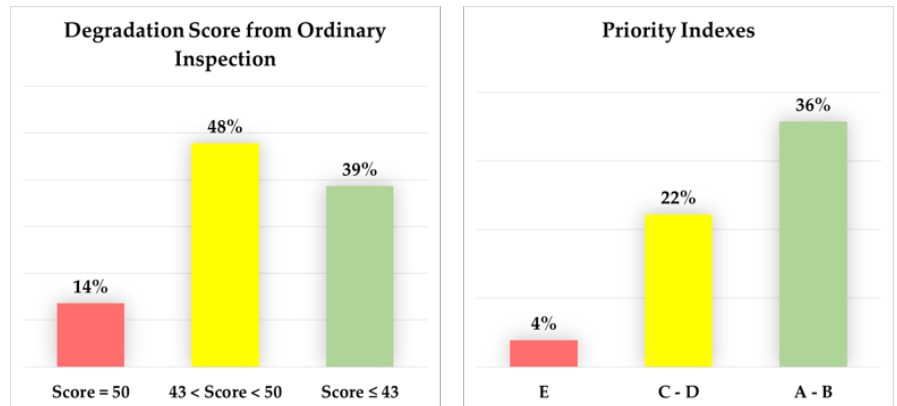
Figure 10. Degradation Score and Priority Index evaluated by Ordinary Inspection Method.